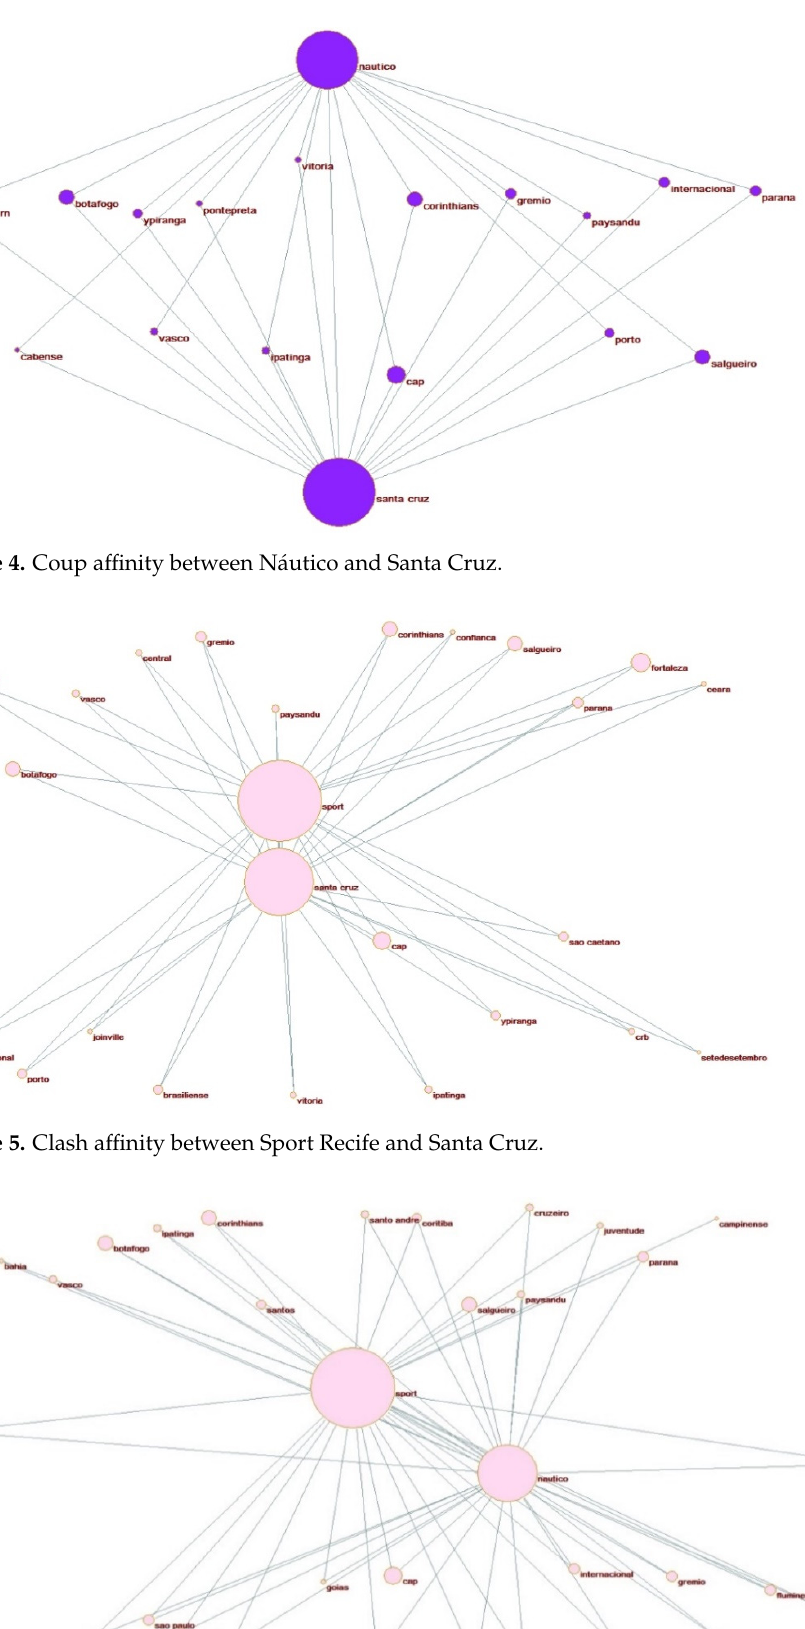
Figure 5. Clash affinity between Sport Recife and Santa Cruz.